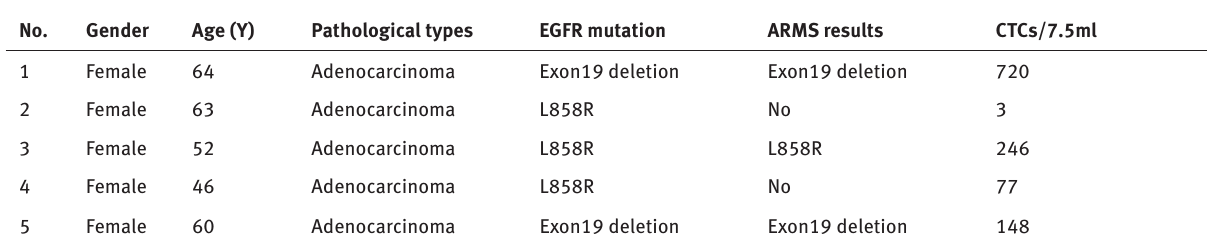
Table 1: Basic information of 5 patients and results of ARMS.